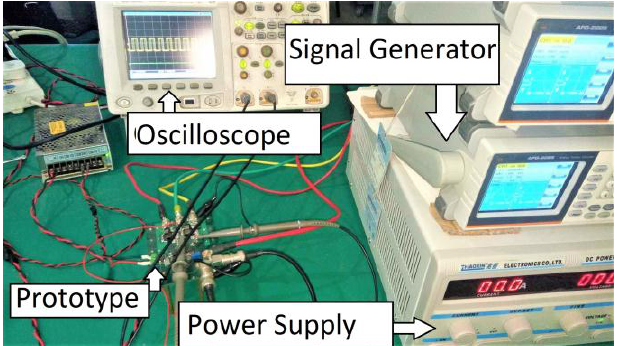
Figure 12. Experimental setup of the half-bridge dc-ac converter with the proposed gate driver.